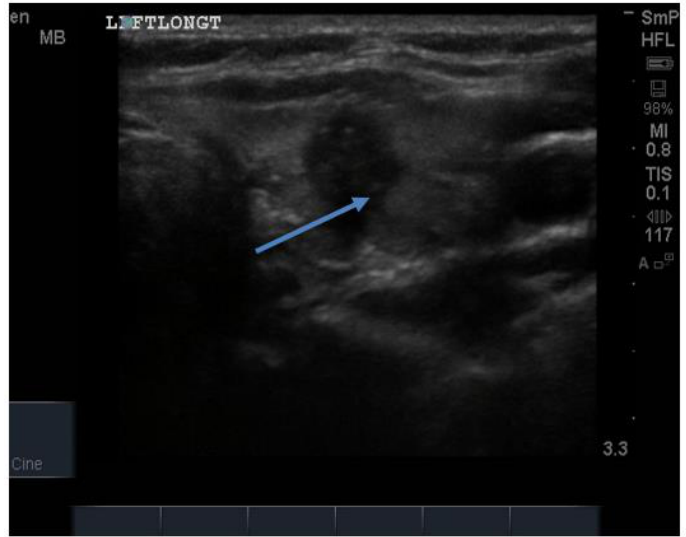
Figure 13. Small 10 mm nodule with an overall blurry irregular edge (arrow) that is taller than wide and hypoechoic, shown from FNAB to be papillary cancer.